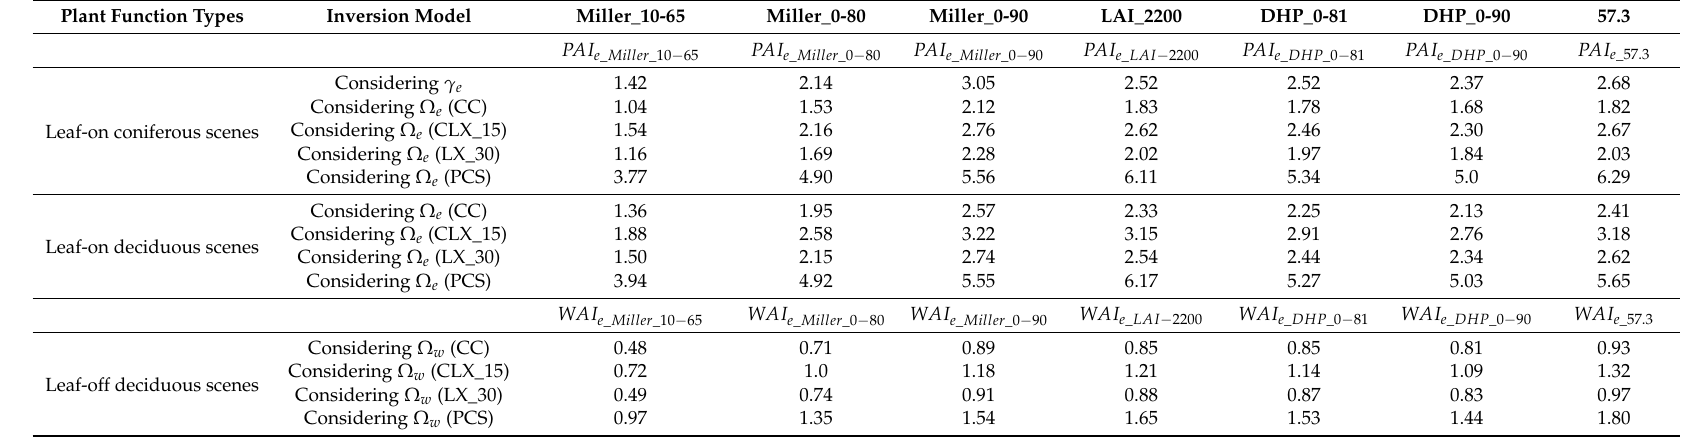
Table 4. Mean PAI e of leaf-on coniferous and deciduous scenes and mean WAI e of leaf-off deciduous scenes, which were derived from the seven inversion models using Equations (3)–(7), (9) and (10) considering γ e , Ω e , or Ω w , respectively ( G e ( θ ) and G w ( θ ) are assumed to be equal to 0.5). γ e is assumed to be equal to 1.0 if Ω e or Ω w was considered in the PAI e or WAI e estimation. PAI e or WAI e